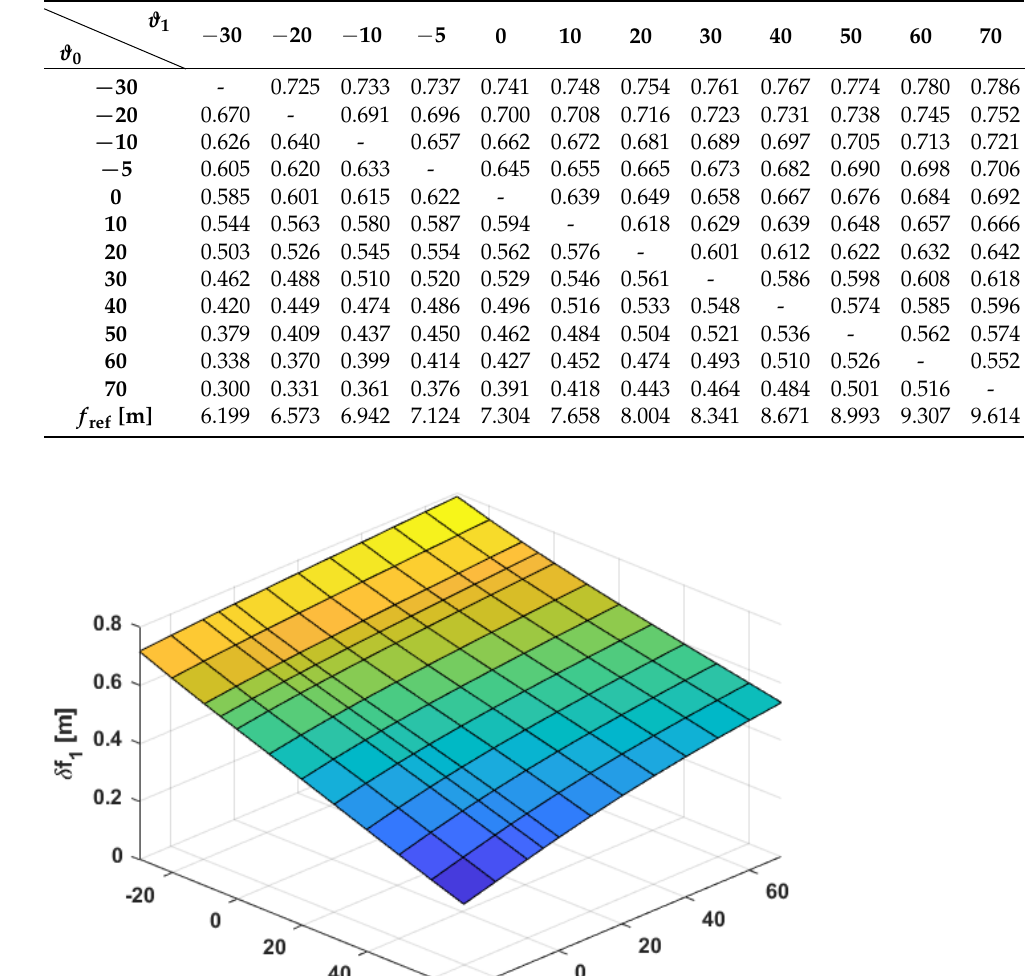
Table 9. Final conductor sag uncertainties δ f 1 [m] caused by the cumulation of uncertainties of state equation input parameters. Temperatures ϑ 0 , ϑ 1 are in ◦ C.